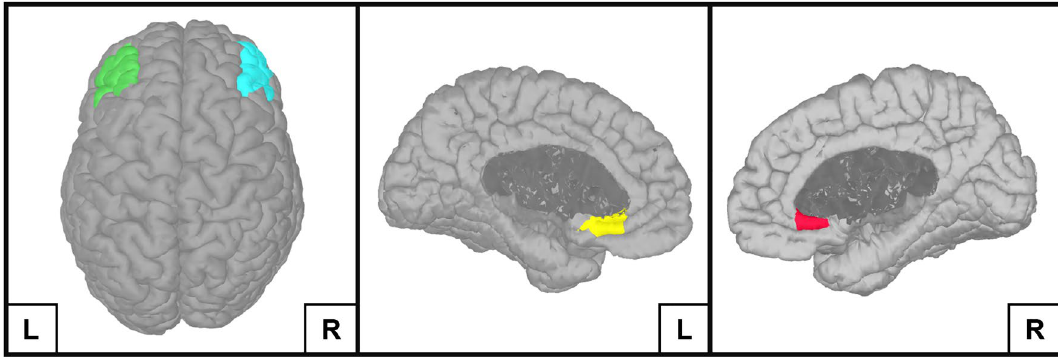
Figure 1. The four ROIs that were used in the source-space functional connectivity analysis performed in Brainstorm. The four ROIs include the left Dorsolateral Prefrontal Cortex (green), right Dorsolateral Prefrontal Cortex (turquoise), left subgenual Anterior Cingulate Cortex (yellow) and the right subgenual Anterior Cingulate Cortex (red).